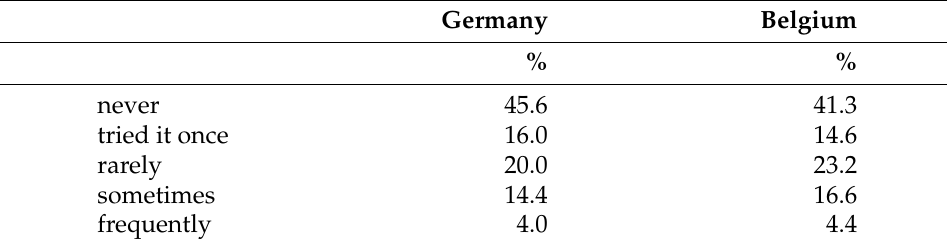
Table 10. Frequency of consumption of meat alternatives such as veggie burgers.